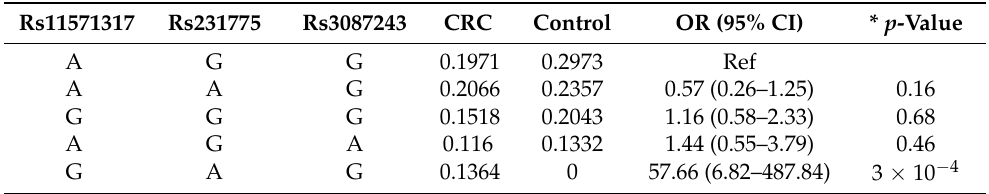
Table 6. Haplotype analysis. CRC, colorectal cancer; OR, odds ratio; 95 % CI, 95 % confidence interval. * p < 0.05 was considered significant.